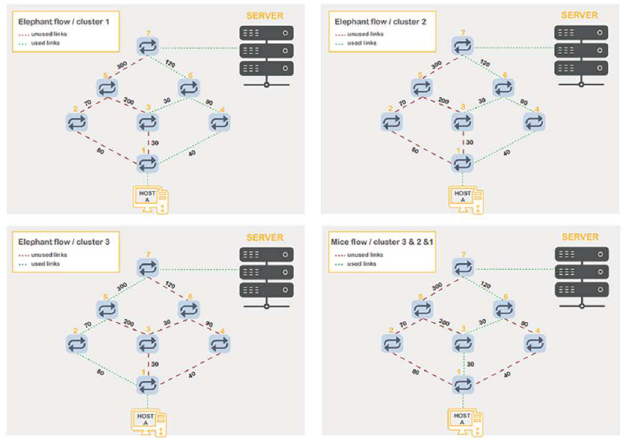
Figure 8. Flow Paths in the Network Using the Proposed Method.